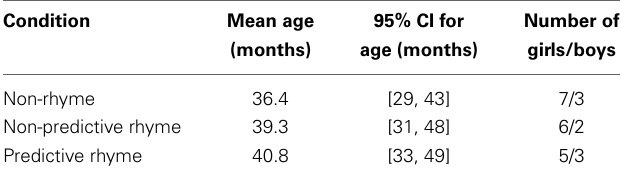
Table 1 | Age and Gender breakdown of each Condition Group in Experiment